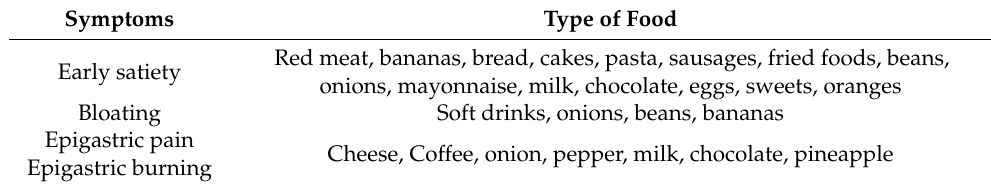
Table 1. Dyspeptic symptoms and certain foods triggering